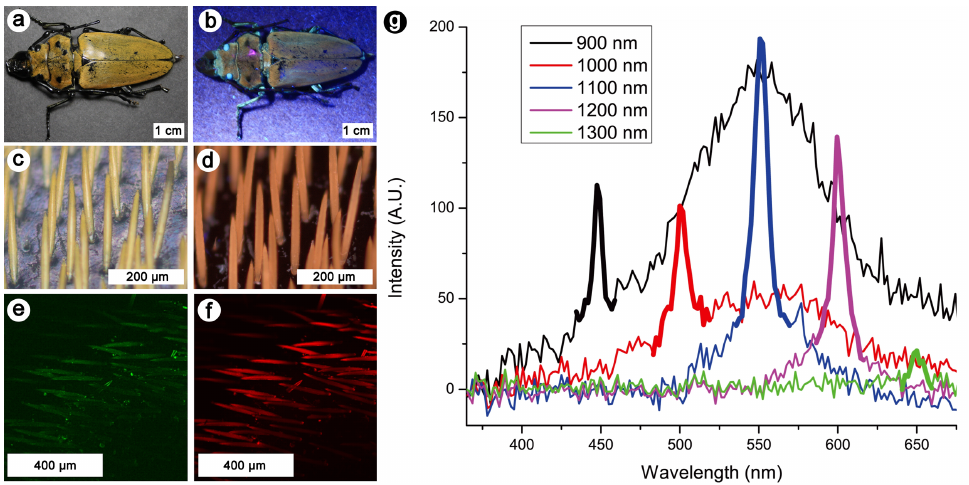
Figure 7. The yellow and fluorescent scales occurring on the elytra of the log-boring beetle T. childreni were investigated by nonlinear optical techniques, including OPEF, TPEF, and SHG microscopy and spectroscopy. The elytra exhibit a yellow colour under both incident visible white ( a ) and UV ( b ) light. This colour is due to the presence of elongated scales covering the elytra ( c , d ). Under visible ( c ) or UV light ( d ), they appear in shades of yellow. Upon excitation with a fundamental wavelength of 1000 nm, a SHG ( e ) and a TPEF ( f ) signal can be detected from the scales (here observed by microscopy in false colours). Multiphoton emission spectra of the log-boring beetle’s scales measured with various excitation wavelengths ( g ) exhibit SHG peaks at half the excitation wavelengths (thick lines). TPEF peaks were observed around 550 nm at most excitation wavelengths. Reproduced